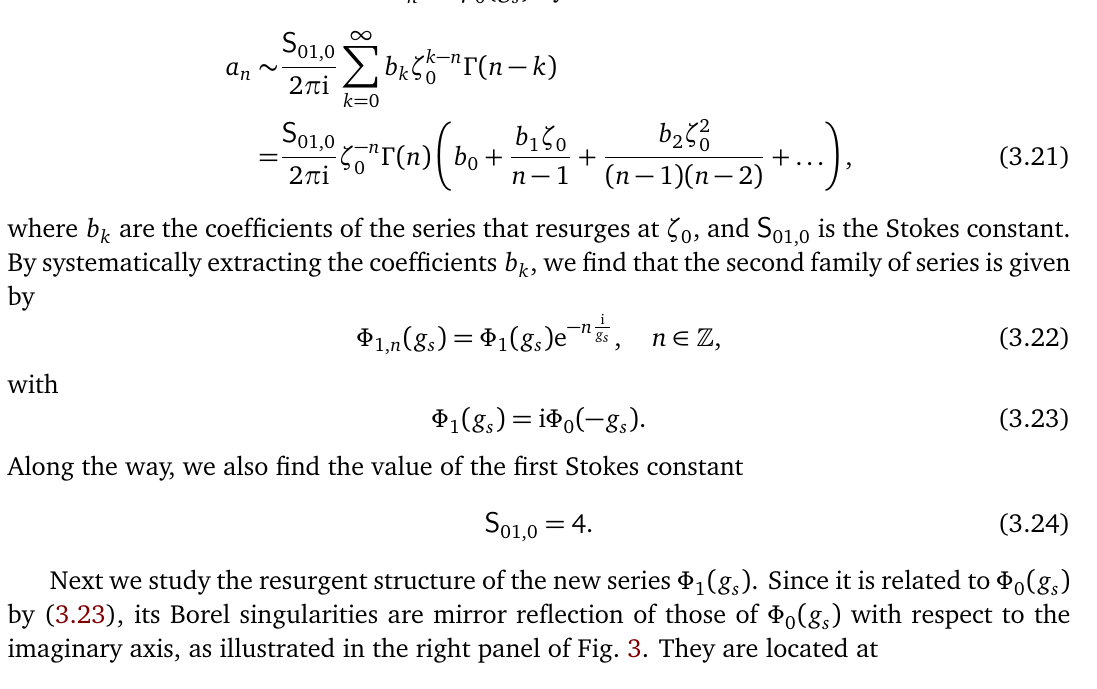
Figure 3: The singularities in the Borel plane for the series ϕ The second tower of singularities indicates the existence of a new family of asymptotic